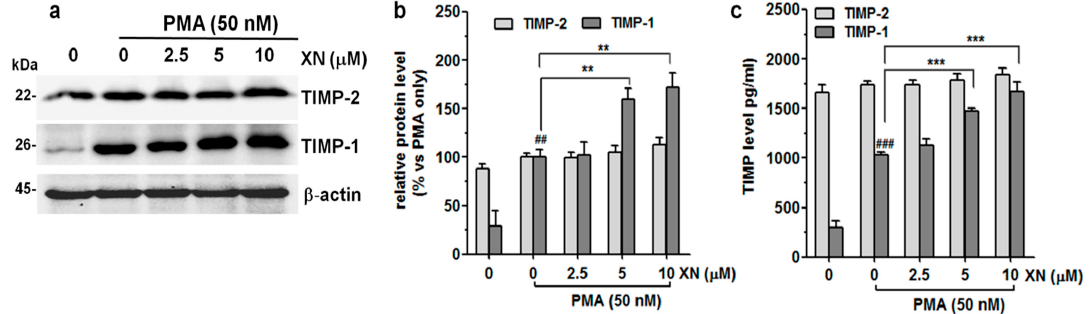
Figure 3. Effect of XN on the endogenous and exogenous production of TIMP-1 and TIMP-2 in PMA-induced A549 cells. ( a ) After the 4-h pre-treatment with XN followed by 24-h co-incubation with PMA, the levels of TIMP-1 and TIMP-2 were determined by immunoblotting. ( b ) The intensity of protein bands from Western blot was quantified by densitometry analysis, where the untreated PMA-induced cells represented 100%. The results are presented as the mean ± SD of three independent experiments, ** p < 0.01, in comparison to the PMA-only treatment, ## p < 0.01 in comparison to the non-stimulated cells; one-way ANOVA test. ( c ) Following the XN treatment, the supernatants from the A549 cell cultures were collected and the levels of TIMP-1 and TIMP-2 were assayed with ELISA. The results are the mean ± SD of three independent experiments, *** p < 0.001 in comparison to the PMA-only treatment, ### p < 0.001 in comparison to the non-stimulated cells; one-way ANOVA